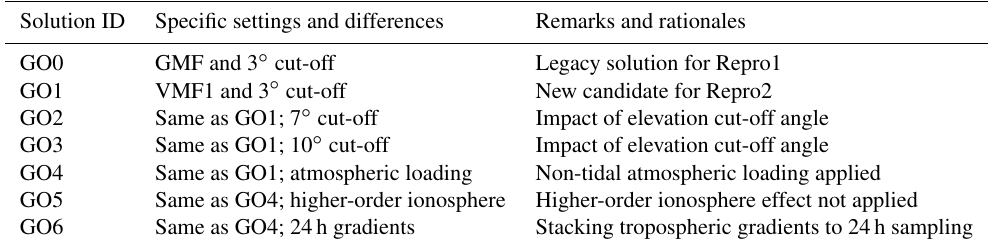
Table 2. GOP solution variants for the assessment of selected models and